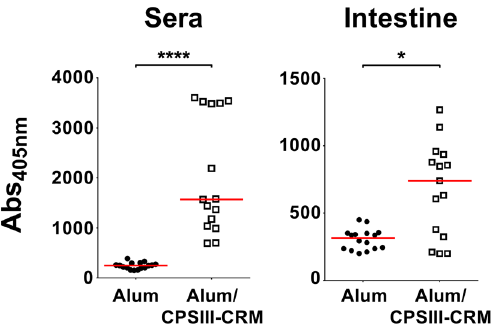
Figure 5. Antibodies against type III polysaccharide were found in blood and mucosal tissues of pups from vaccinated mothers. Anti-CPSIII IgG titres measured in the blood or intestinal homogenates (intestine) seven days after challenge with GBS are expressed as the intensity of absorbance at 405 nm. Each dot represents a single animal and the red horizontal line is the median value of the group. *P < 0.05; ****P < 0.0001 (Mann– Whitney U